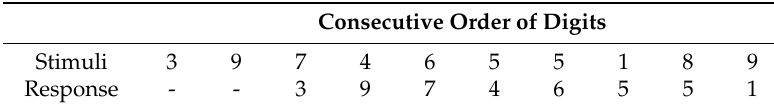
Table 1. N-back task in high level—2-back task.